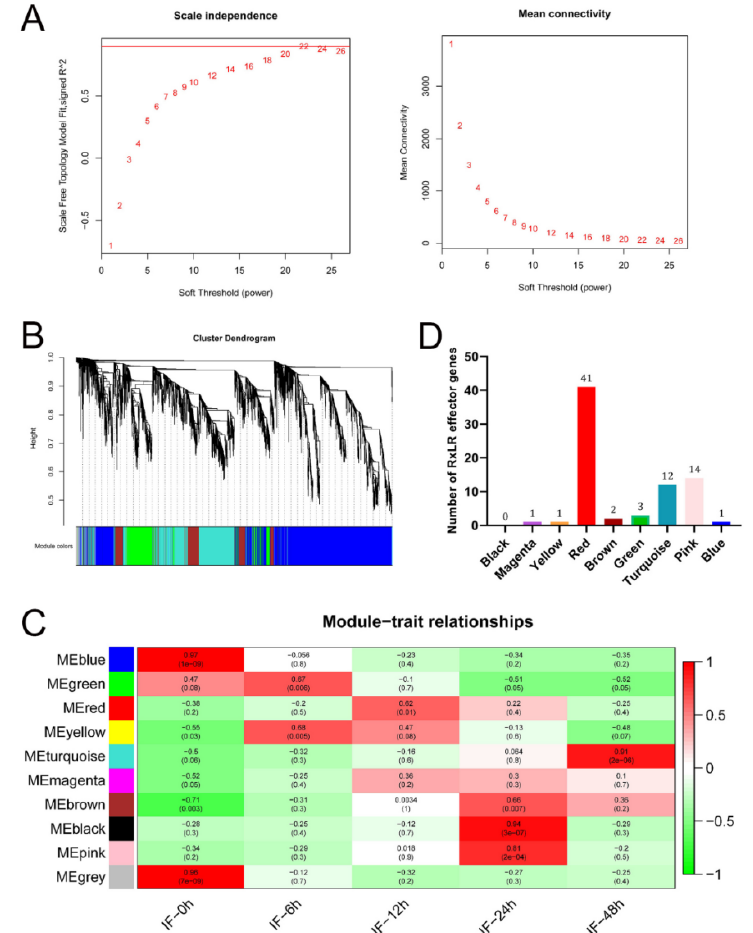
Figure 2. Construction of weighted gene co-expression network analyses (WGCNA) and module detection. ( A ) Analysis of the scale-free topology model fit index for soft threshold powers ( β ) and the mean connectivity for soft threshold powers. Left, the scale of the free fit index ( y axis) as a function of the soft thresholding power ( x axis). Right, the mean connectivity (degree, y axis) as a function of the soft thresholding power ( x axis). The β value was set to ensure the high-scale independence (near 0.9) and low mean connectivity (near 0). ( B ) Module assignment in hierarchical clustered genes. Genes within different modules are labeled with different colors according to the WGCNA’s conventions. Ten co-expression modules were constructed and shown with distinct colors. The grey module contains all genes that were not involved in clustering and thus were not applied to subsequent analysis. ( C ) Matrix showing a module–trait relationship. Each row corresponds to a module. Each column corresponds to a time result. The module–trait relationship is colored based on their correlation, and red and green colors indicate strong positive and negative correlations, respectively. ( D ) Distribution of differentially expressed RxLR effectors in different modules. The number of RxLR effectors was counted after all modules filtered by the criteria that have weight value greater than 0.15.